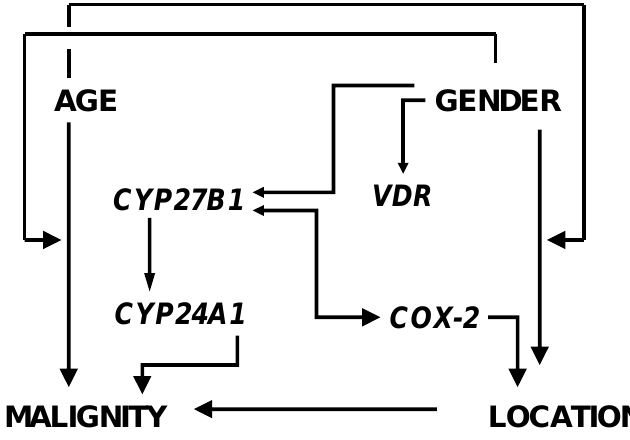
Figure 5. Patient level analysis of mutual correlations between malignancy, age, gender, subsite location, CYP27B1 , CYP24A1 , VDR and COX-2 (see also [2]).